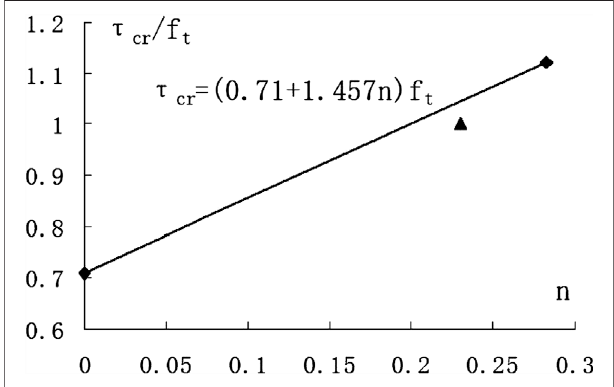
FIGURE 14 | τ cr / f t − n relative